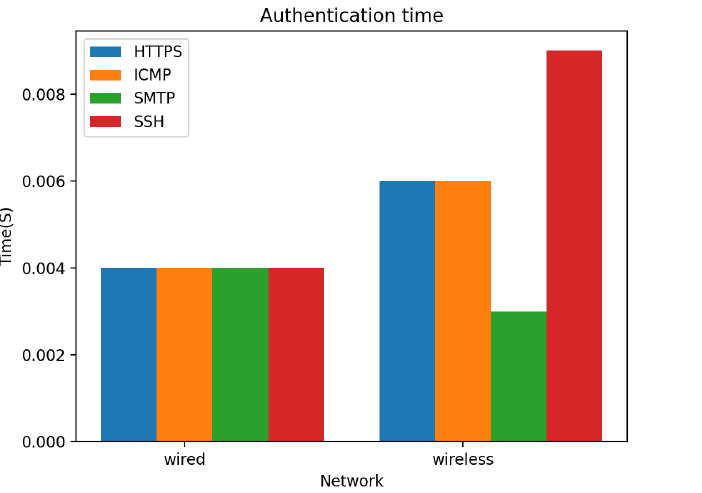
Figure 13. Simulation results showing the time required for authentication and sending